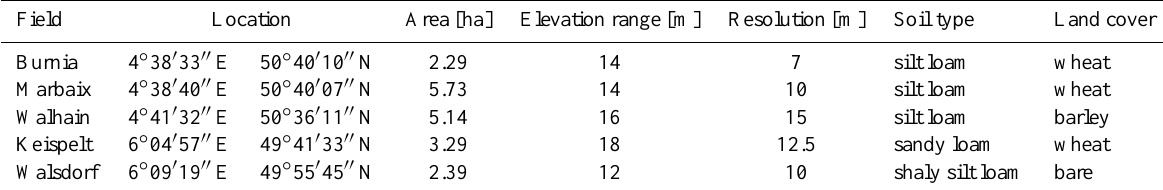
Table 1. Description of the agricultural fields and resolutions used in hydrologic simulations.